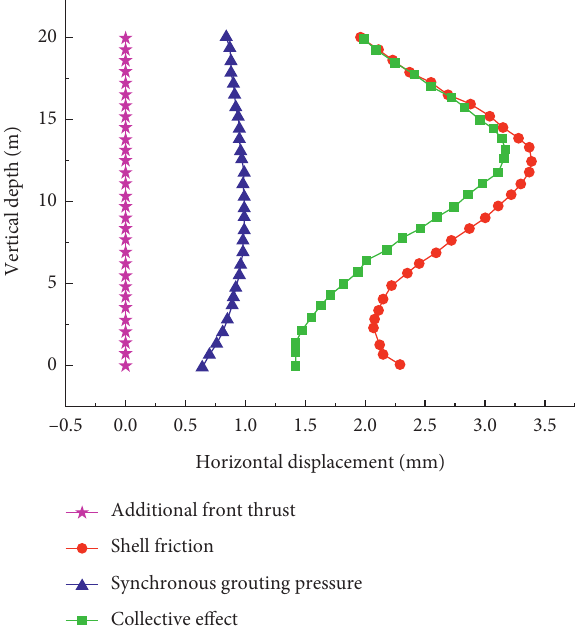
Figure 12: Horizontal deformation of the soil around the shield y along the Y